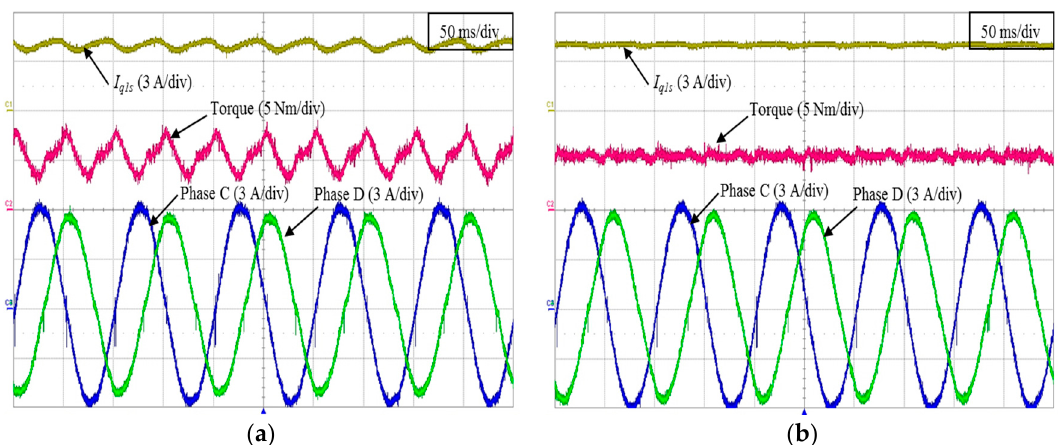
Figure 17. Experimental result of fault ‐ tolerance under open fault phases B in i q1s = 4 A and 300 rpm: ( a ) Without tolerant control; ( b ) With tolerant control.